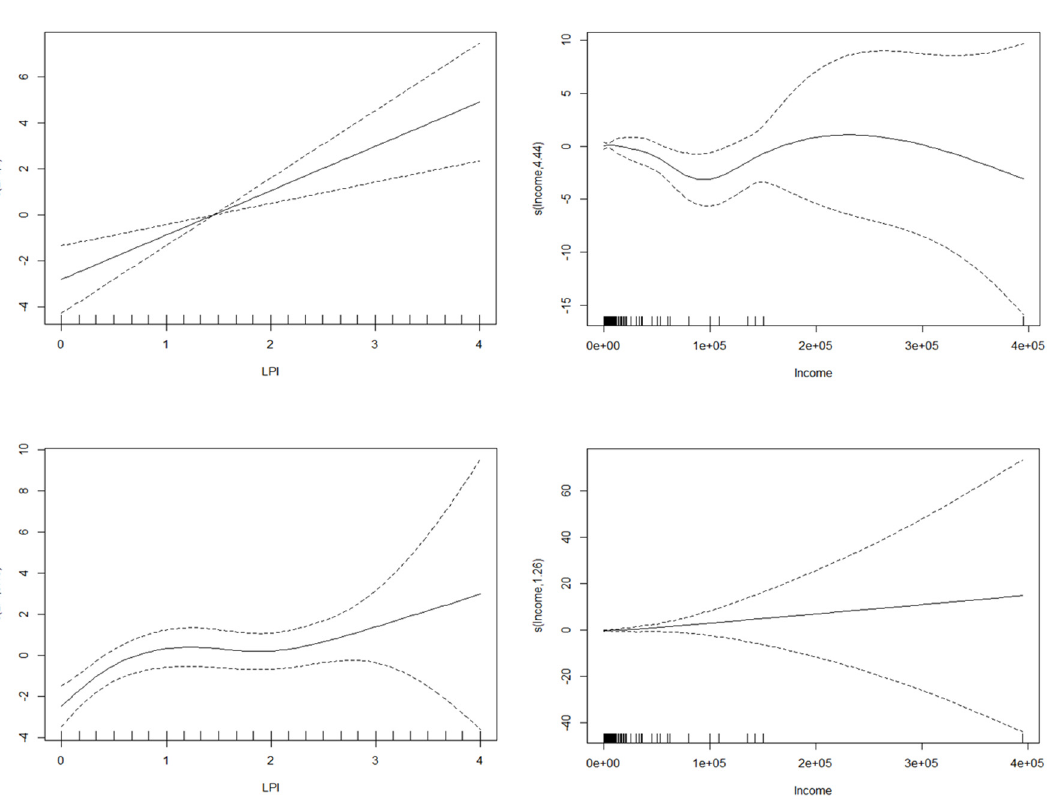
Figure 4. Nonlinear effects of LPI and income, with the estimated line provided as the solid central line accompanied by 95% con fi dence band, shown as do tt ed lines.